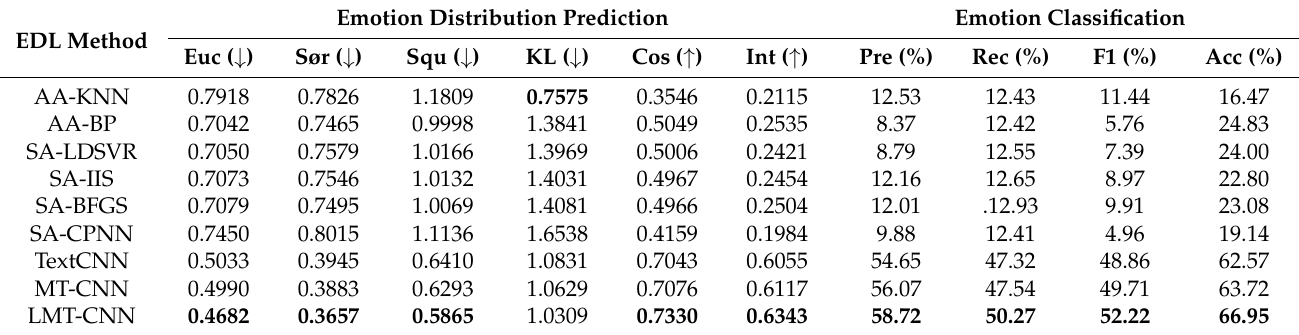
Table 5. Experimental results comparing the performance of 9 emotion distribution learning methods for emotion distribution prediction and emotion classification on the Ren-CECps dataset ( ↑ indicates that the larger the indicator is, the better; ↓ indicates that the smaller the indicator is, the better). The best performances of each indicator are marked in